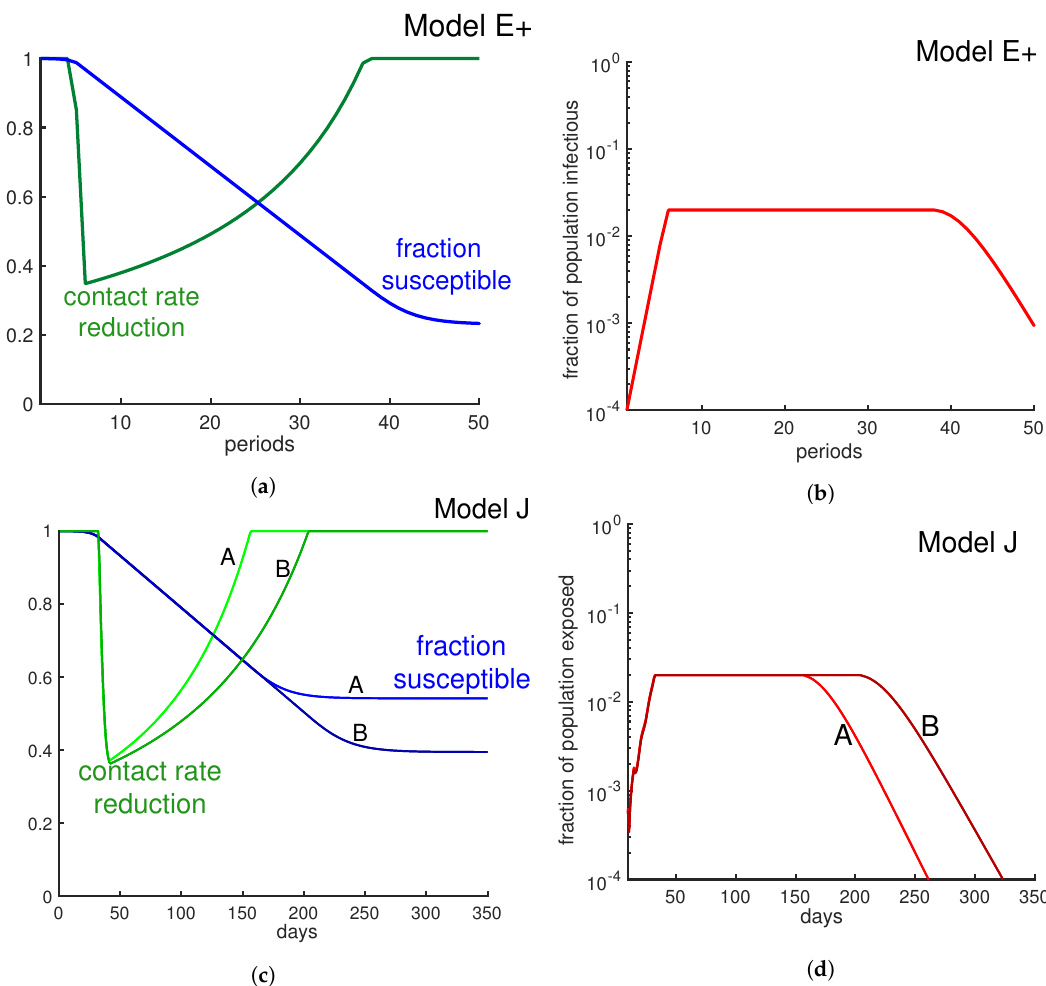
Figure 9. Limit β to limit the infectious fraction. Here we change the contact rate weekly in order to keep the fraction of infectious individuals below 2%. The green curves in panel ( a ) and panel ( c ) represent weekly contact rate reduction. As the panels ( b ) and ( d ) illustrate, the fraction of infectious individuals never goes beyond 2% per week. Panel ( b ) is derived from Model E+ and panel ( d ) is derived from Model J. Alternative strategies include minimizing the contacts of those with risk